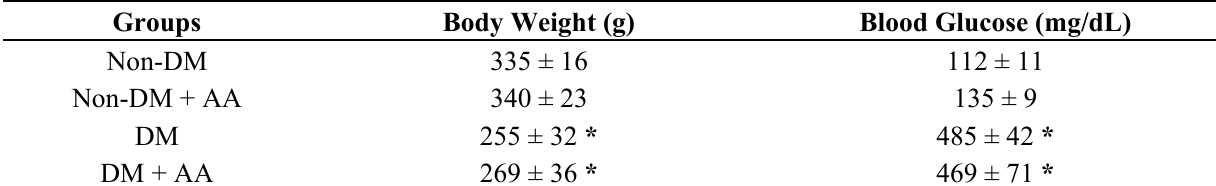
Table 1. Effects of oral supplementation with AA on body weight and blood glucose levels in nondiabetic (non-DM) and diabetic (DM) groups of